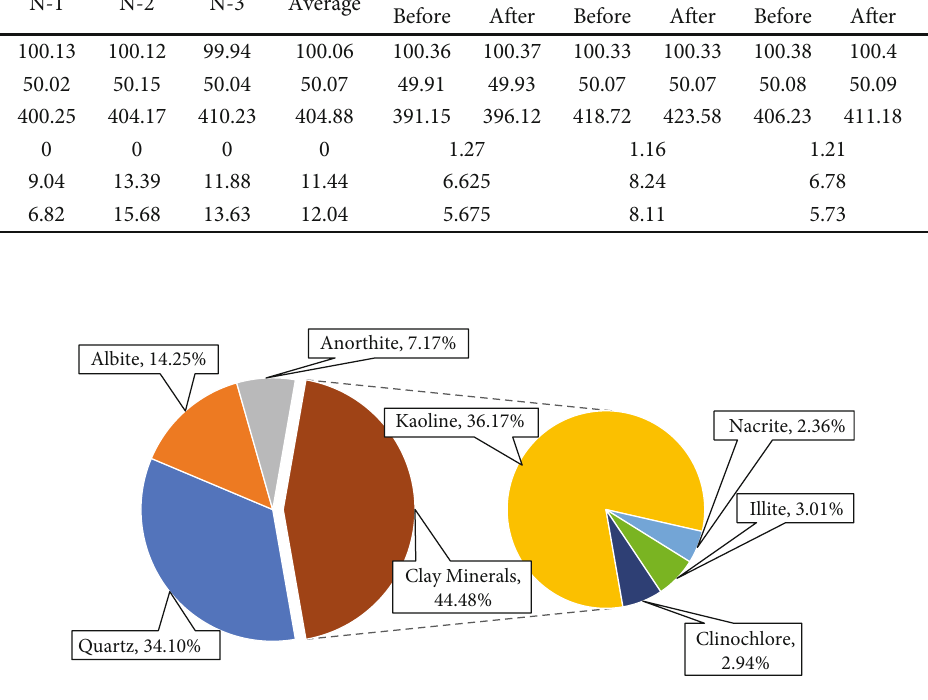
Figure 4: Types and contents of the main mineral components tested by